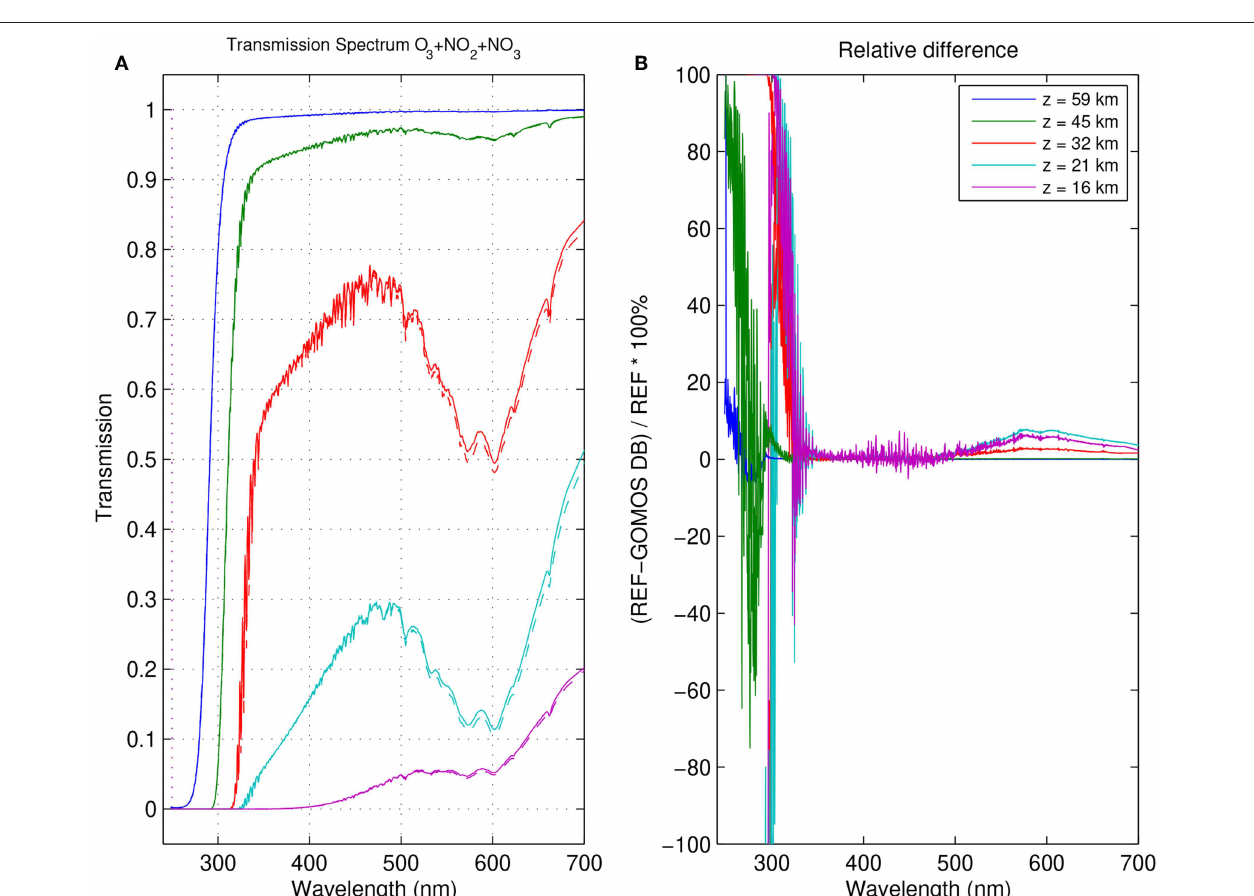
FIGURE 10 | (A) Forward model transmittance constructed from the gas and aerosol profiles corresponding to the total transmittance at different altitudes for the GOMOS occultation measured on August 23rd, 2007 at latitude 32 ◦ S and longitude 102 ◦ E. Atmospheric conditions considered for the calculation of the local absorption/scattering cross-sections are taken from the meteorological fields provided in the GOMOS data product. Figure shows the model built with the revised cross-section database (solid) and GOMOS DB (dashed). The spectral range corresponds to the GOMOS spectrometer SPA. (B) Relative difference between the forward models computer with the revised cross-section database and with GOMOS